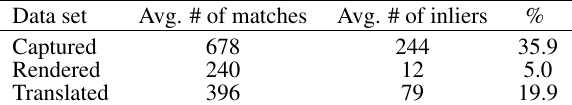
Table 1. Average numbers of total matches and inliers between test images and training images. The test images are the cap- tured images from the Shop Fac¸ade test sequence. The last col- umn shows the percentage of average inliers in relation to the average matches.